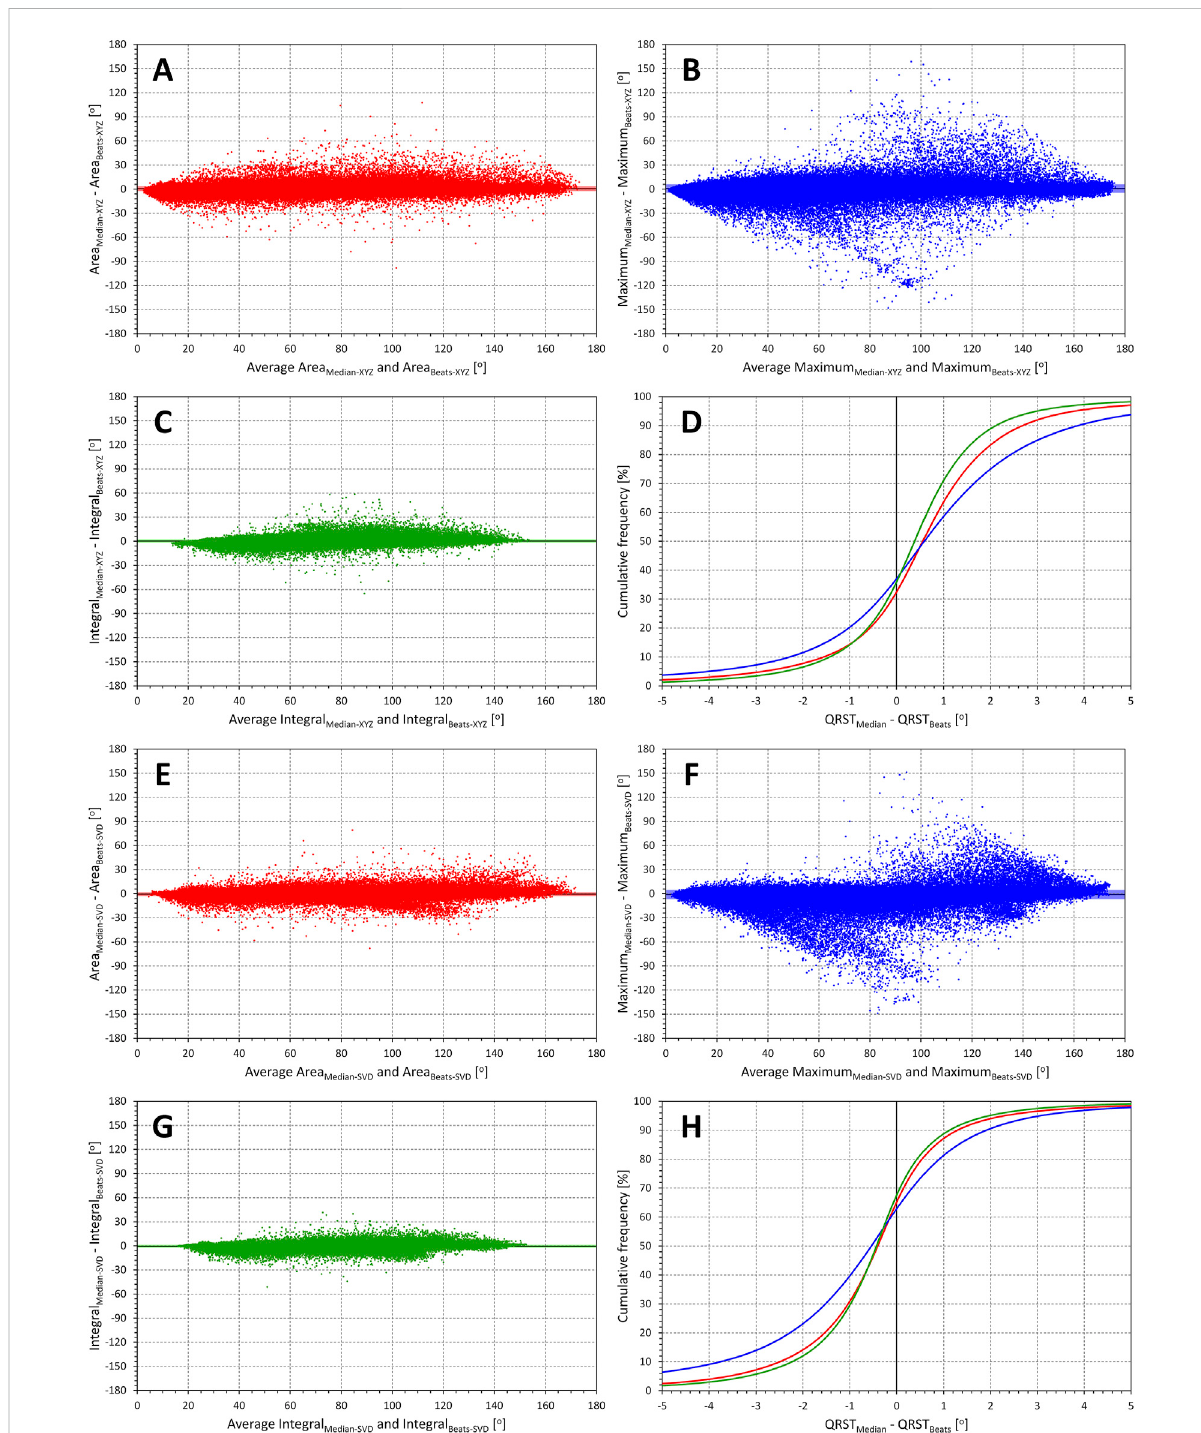
FIGURE 2 Comparisons of QRS-T angle measurements in individual beats and representative waveforms. Bland-Altman type of comparisons between QRS-T angle expressions measured at the representative waveform of 10-s ECG segments with the averages of the same angle expressions measured at individual beats of the same ECG segment. The layout of the fi gure and of the individual panels corresponds to that of Figure 1, with all the measurements in all study subjects pooled. In the method indicators, additional subscripts Median and Beats indicate measurement value derived from representative median waveform and obtained as an average of individual beats of the ECG segment, respectively. Panels ( A , B) and (C) show the comparisons for the Area XYZ , Maximum XYZ , and Integral XYZ angle measurements, respectively; panel (D) again shows the